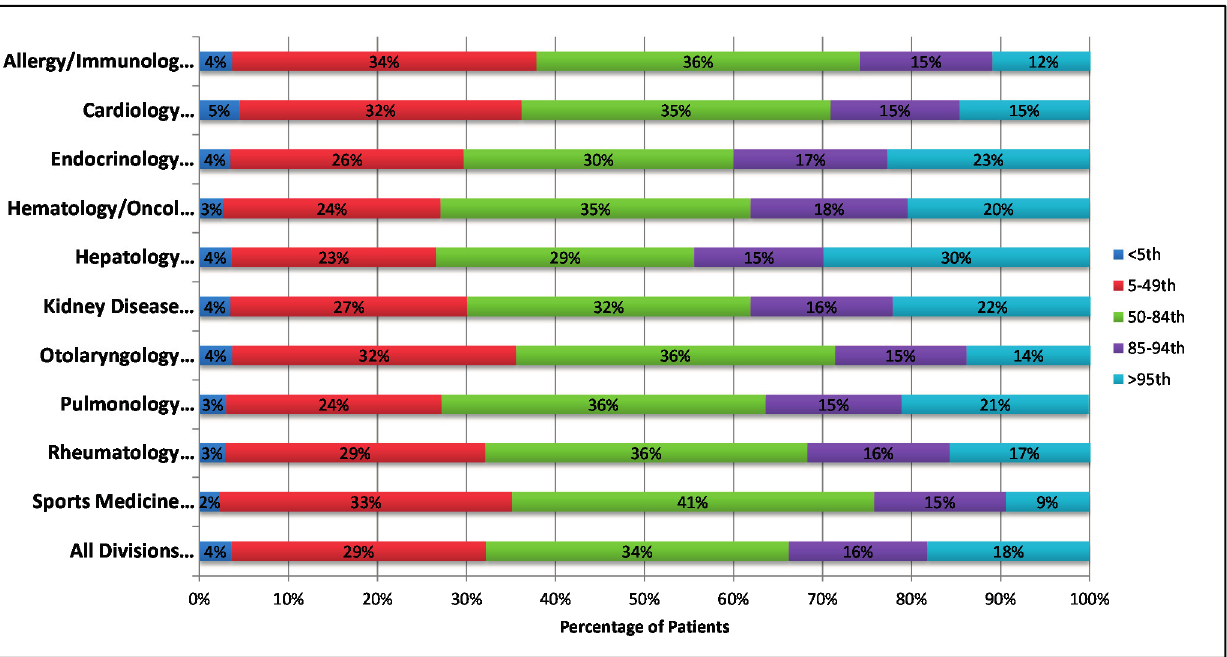
Figure 2. Excluding primary care divisions, obesity identification varied from 2% to 40% across subspecialties. Additionally, 79% of obese patients who were not identified throughout the study year were seen at outpatient visits in more than one division or service. Figure 1. Distribution of BMI Percentile Categories across Participating Divisions/Services.